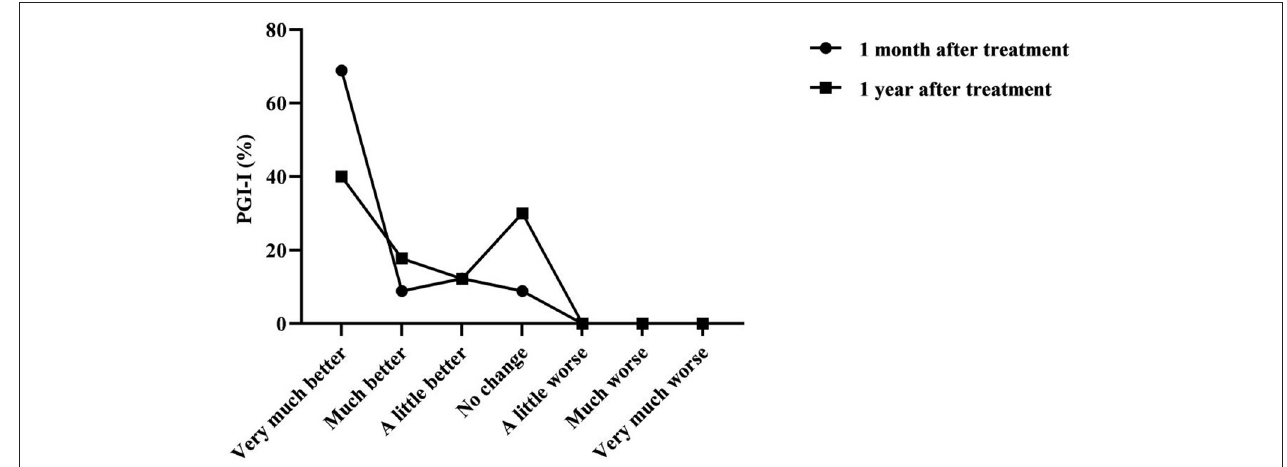
FIGURE 1 | The Patient Global Impression of Improvement (PGI-I) at 1 month and 1 year after treatment with Modified Buzhong Yiqi Decoction ( n = 90).